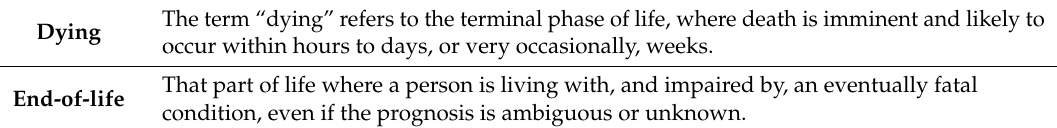
Table 2. End-of-life care terminology